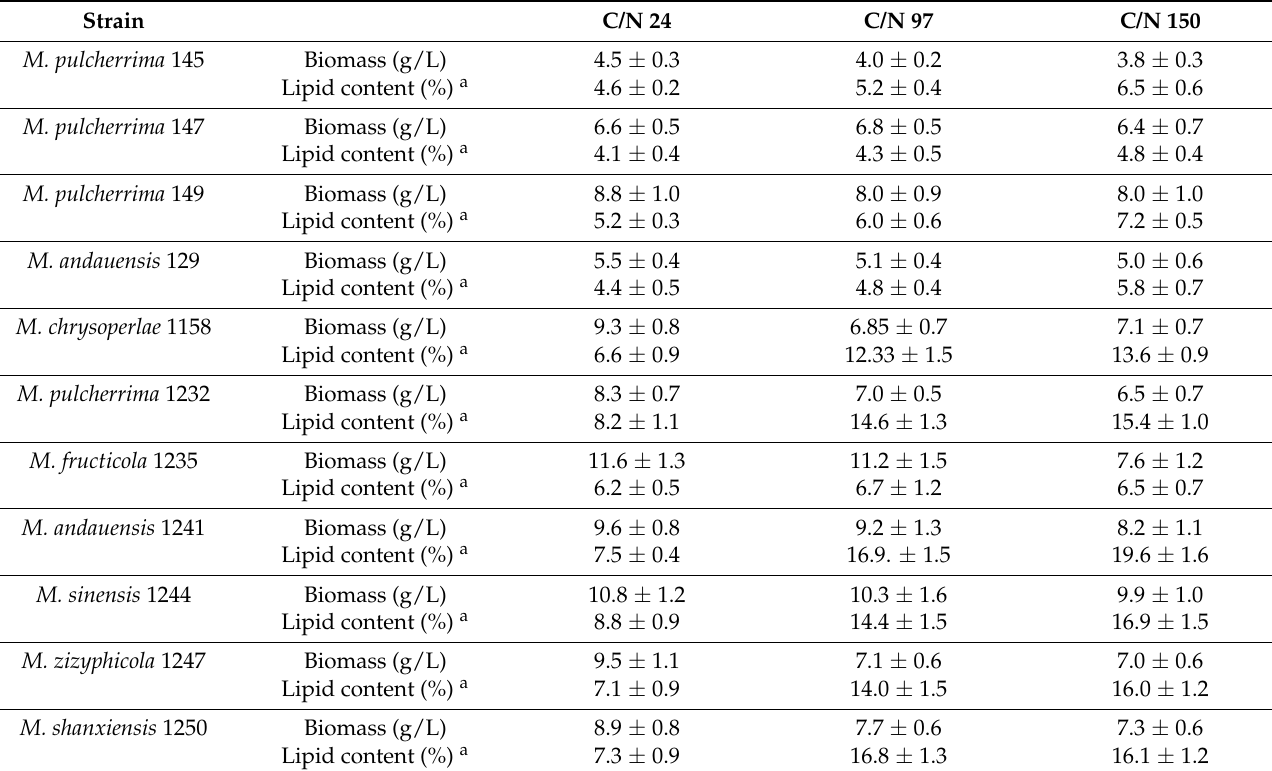
Table 5. Biomass and lipids production at low temperature cultivated on glucose medium with different C/N ratio.